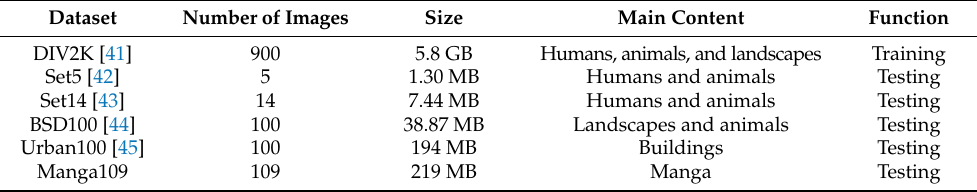
Table 1. Characteristics of the dataset used for